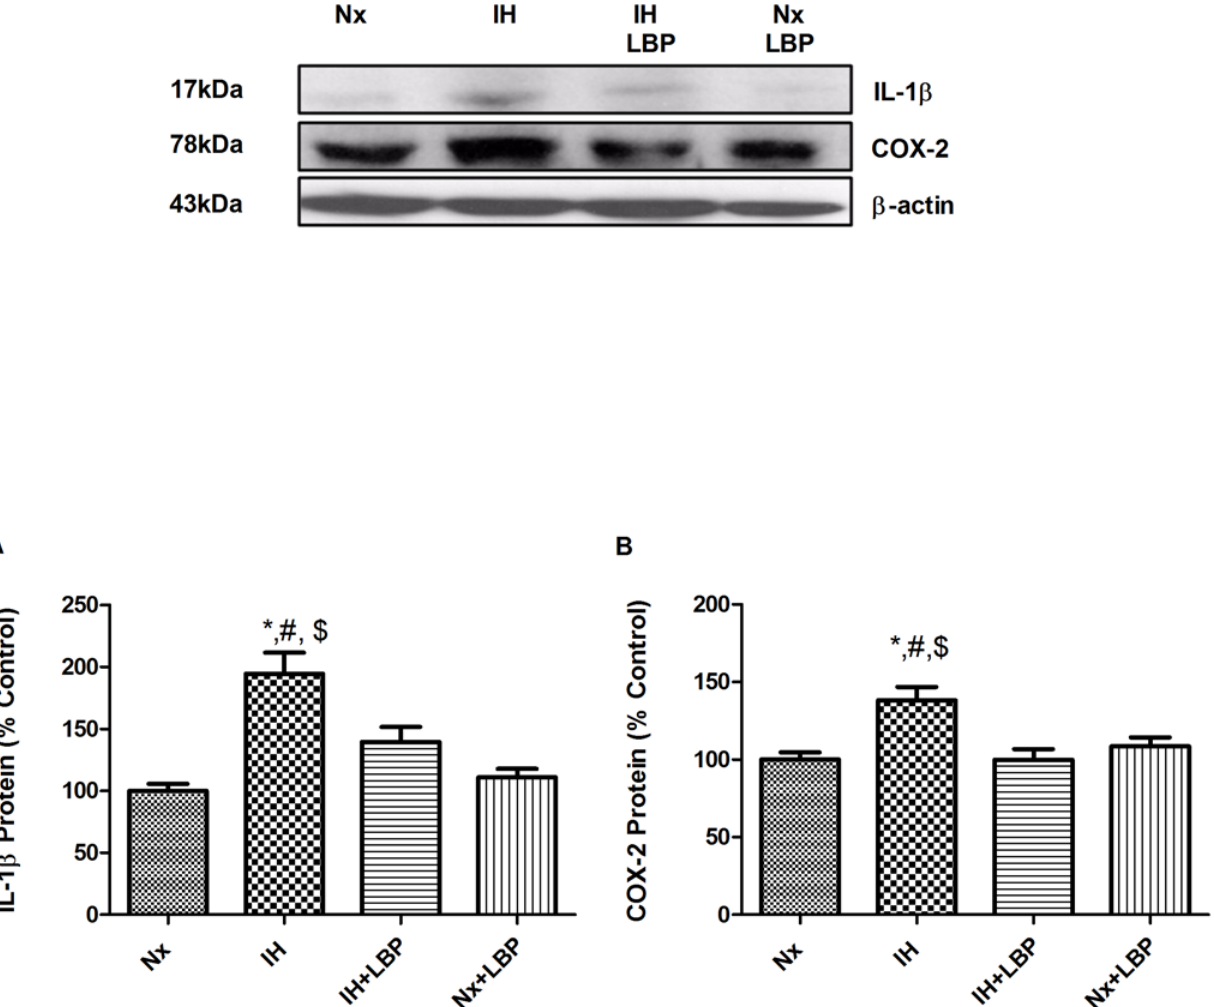
Fig 7. LBP downregulated NF К B-dependent inflammatory cytokine and mediator. Levels of the protein expression (upper panel) of (A) IL-1 β and (B) COX-2 in the hippocampus of the normoxic (Nx) or hypoxic (IH) groups; LBP-treated hypoxic (IH+LBP) or normoxic (Nx+LBP) groups are summarized. β -actin was an internal control. Data are mean ± SEM (n = 6 – 8). * p < 0.05 when compared with Nx, # p < 0.05 when compared with IH+LBP, $ p < 0.05 when compared with Nx+LBP